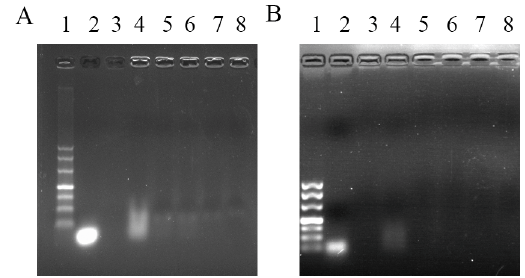
Figure 3. siRNA was encapsulated by Arg-CS and retarded by electrophoresis in agarose. ( A ) Arg-CS and ( B ) CS were used to encapsulate siRNAs. Lane 1: DNA marker (from top to bottom of the lane: 500 bp, 400 bp, 300 bp, 200 bp, 150 bp, 100 bp, and 50 bp); lane 2: siRNA; lane 3: Arg-CS or CS; lanes 4–8: weight ratios of Arg-CS or CS to siRNA equal to 1:1, 10:1, 20:1, 50:1, and 100:1, respectively. The concentrations of Arg-CS and siRNA were 0.02 μ g/ μ L. The concentration of NaAc was 0.1 M (pH = 5.5).